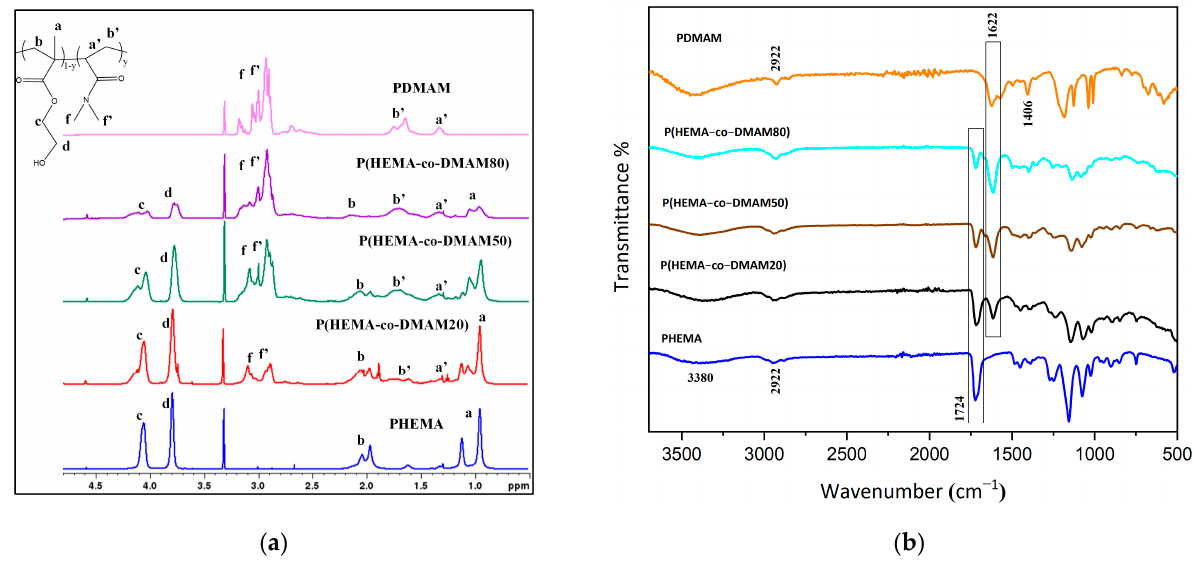
Figure 2. ( a ) 1 H NMR spectra of the P(HEMA-co-DMAMy) copolymers in d 4 -MeOH. The spectra of the homopolymers PHEMA and PDMAM, are also presented.; ( b ) ATR-FTIR spectra of the P(HEMA-co-DMAMy) copolymers. The spectra of the homopolymers PHEMA and PDMAM, are also presented.